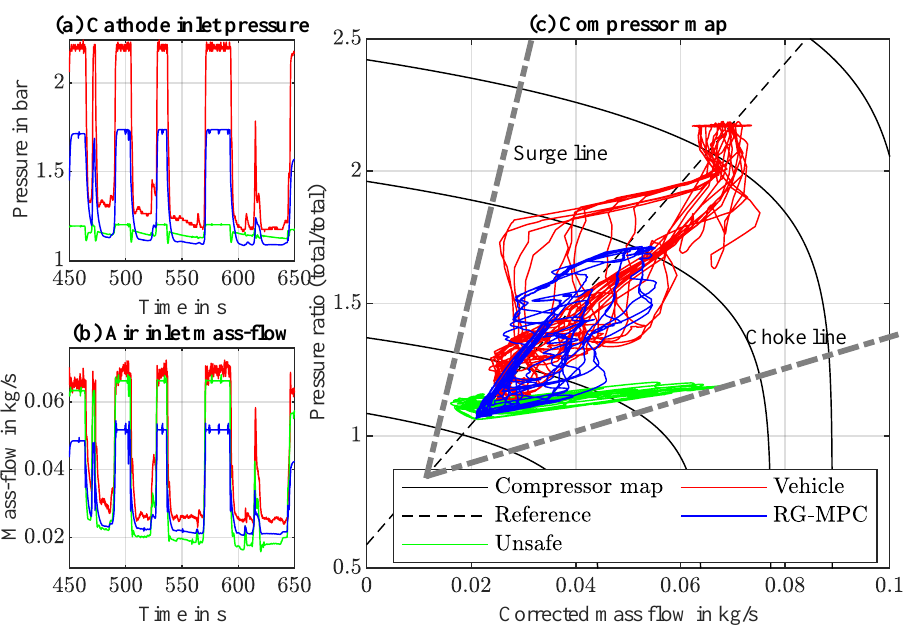
Figure 11. ( a ) Cathode inlet pressure, ( b ) air inlet mass-flow, ( c ) compressor